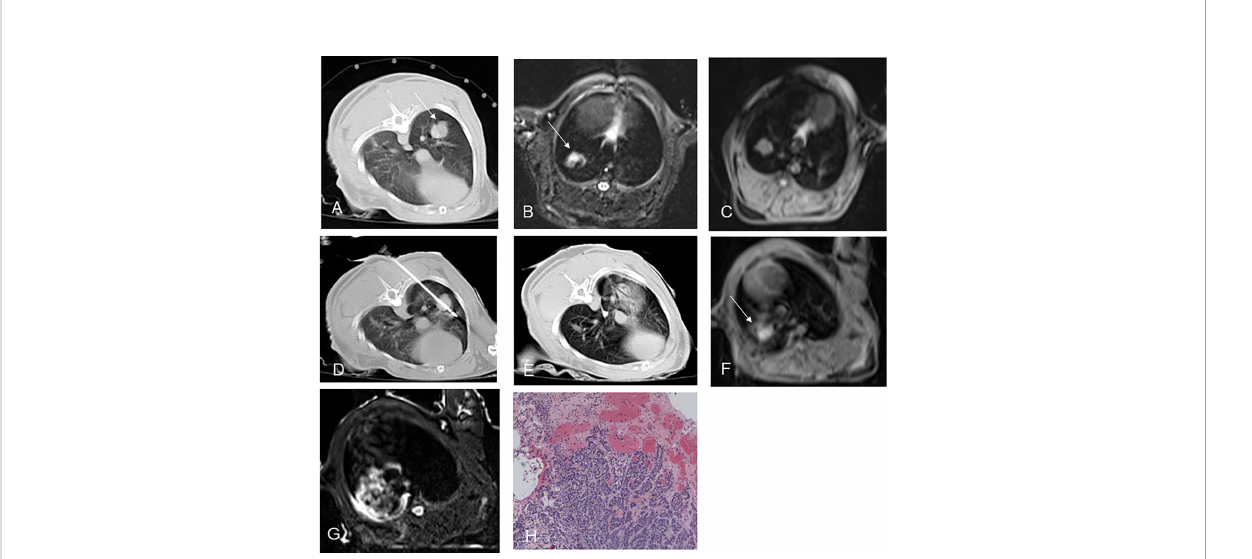
FIGURE 2 CT-guided RFA for rabbit lung VX2 tumor with MR and pathological fi ndings. CT showed a VX2 tumor located in right lower lobe with 12 mm in diameter ( A , arrow). The pre-ablation MR scan of the tumor showed hyperintensity on T2WI and isointensity on T1WI before RFA ( B, C , arrow). Radiofrequency electrode was gradually punctured into the tumor under CT guidance (D) . GGO surrounding the lesion with 5 mm beyond was displayed immediately after RFA on CT (E) . Immediately after RFA, MR showed short T1 and short T2 signals in the central area and patchy iso-T1 and long T2 signals in the periphery ( F, G arrow). Pathology showed coagulative necrosis of the ablation foci, with peripheral hemorrhage and in fl ammatory reaction zone (H) . RFA, radiofrequency ablation; T2WI, T2-weighted image; T1WI, T1-weighted image; GGO, ground-glass